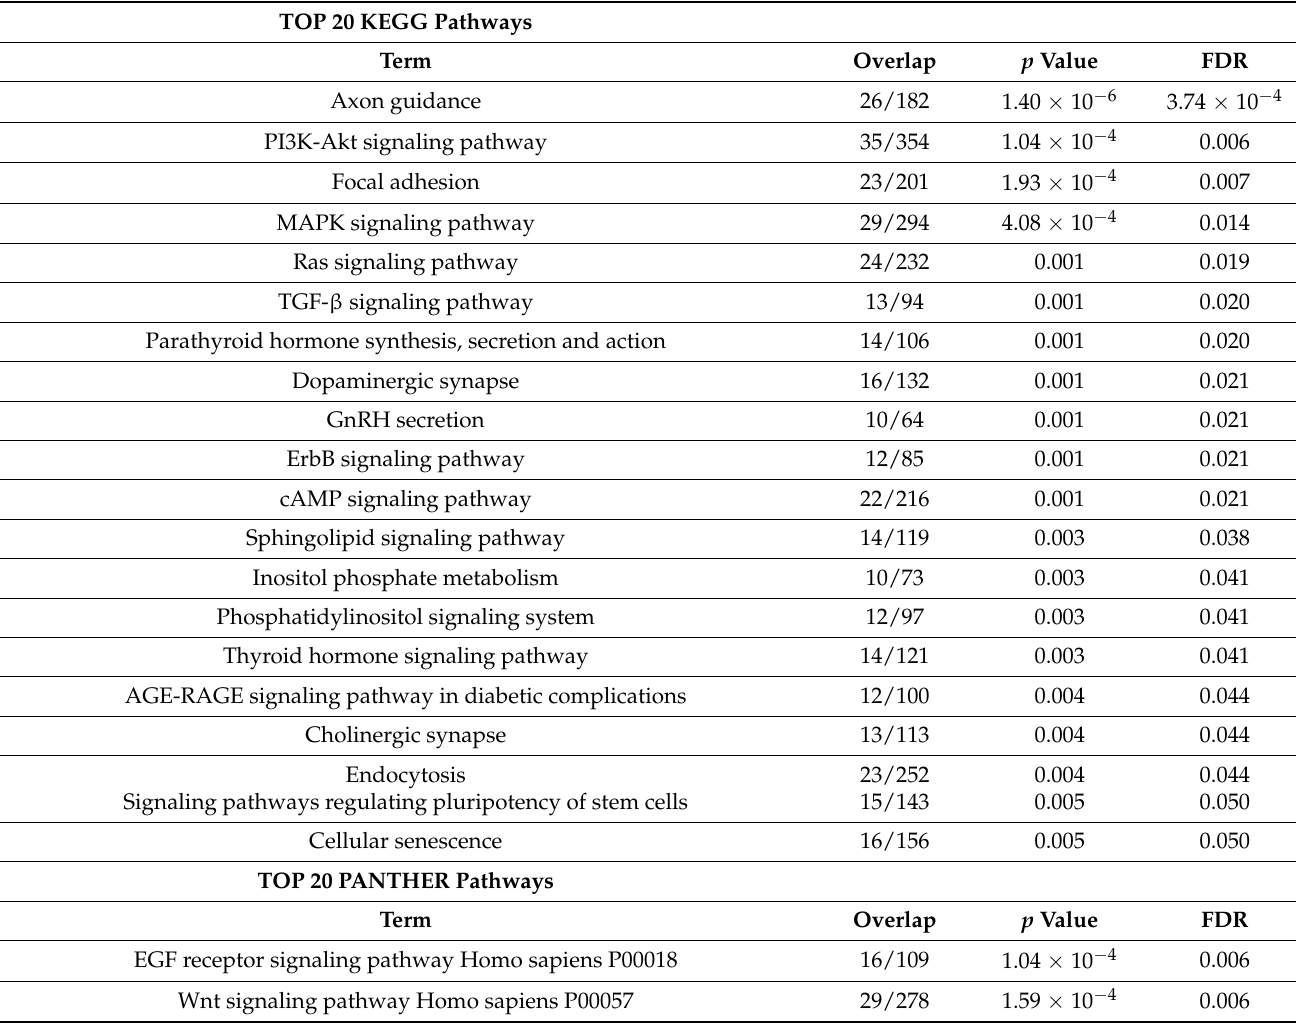
Figure 2. Venn diagrams of bioinformatics target prediction for miR-101-3p ( A ) and miR-142-5p ( B ). Table 2. Bioinformatic analysis of miR-101-3p target genes. The table reports the 20 most representa- tive terms of pathways and GO analysis of miR-101-3p target genes.